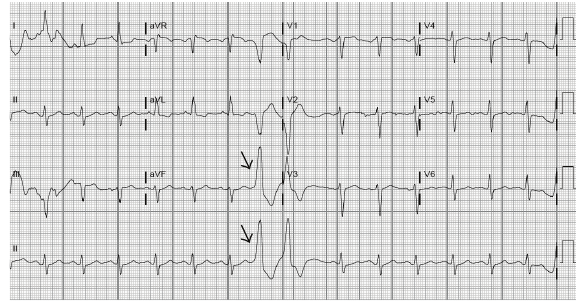
Figure 1: EKG shows normal sinus rhythm with frequent premature ventricular complexes (Arrows).